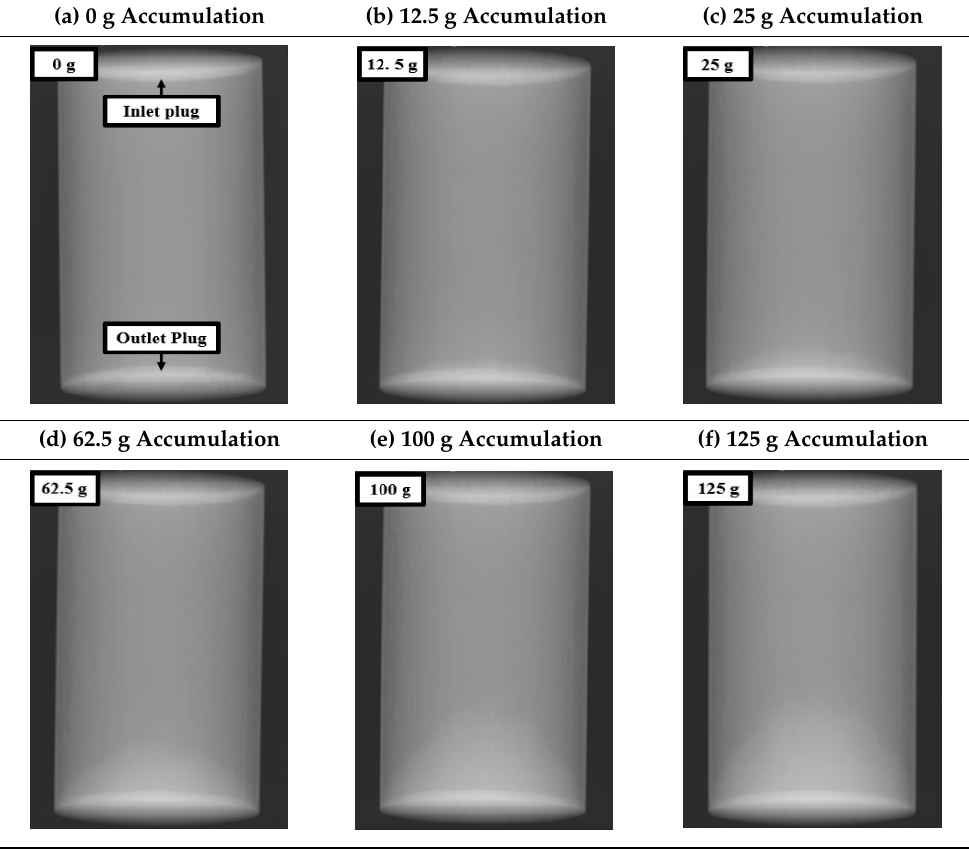
Table 5. The substrate images of six different conditions (carbon powder from 0 g to 125 g).